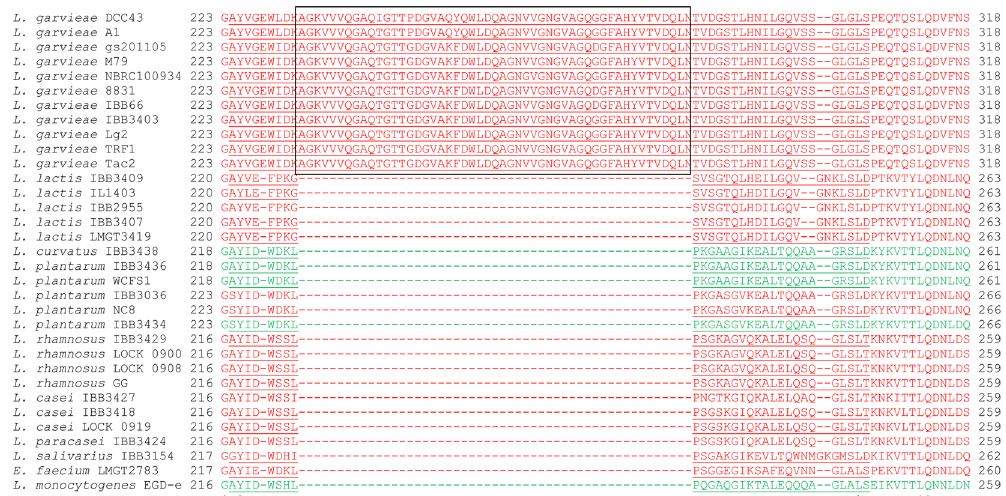
Figure 4. Multiple sequence alignment of the amino acid sequences of Man-PTS subunits IID from various bacterial species. Extracellular and intracellular regions are marked in red and green, respectively. Region γ is underlined, region γ+ is boxed. Asterisks, double dots and single dots indicate fully, strongly and weakly conserved residues, respectively. The accession numbers are WP_003134976.1 for L . garvieae DCC43, WP_081164986.1 for L . garvieae A1, WP_046400791.1 for L . garvieae Lg-ilsanpaik-gs201105, WP_042218841.1 for L . garvieae NBRC100934, WP_017368922.1 for L . garvieae 8831, ETD04540.1 for L . garvieae TRF1, WP_074750596.1 for L . garvieae M79, WP_004258904.1 for L . garvieae Lg2, WP_017370845.1 for L . garvieae Tac2, NP_267864.1 for L . lactis IL1403, YP_004888576.1 for L . plantarum WCFS1, WP_003640910.1 for L . plantarum NC8, WP_005685034.1 for L . rhamnosus LOCK 0900 L . rhamnosus LOCK 0908 and L . rhamnosus GG, WP_003568236.1 for L . casei LOCK 0919, NP_463631.1 for L . monocytogenes